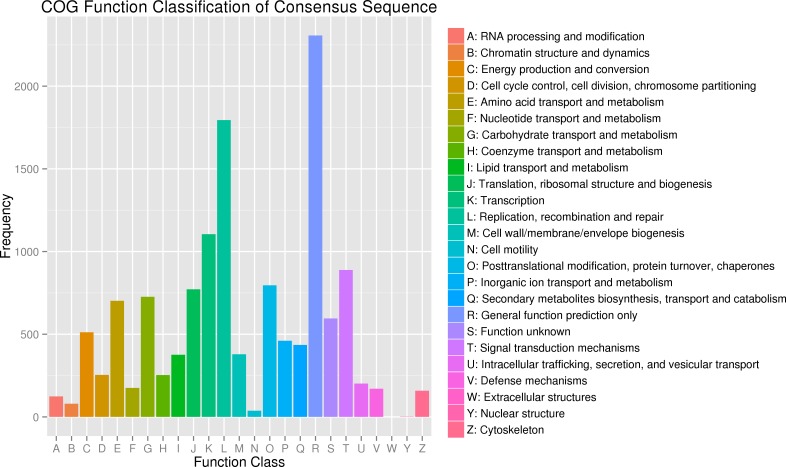
Clusters of orthologous group (COG) classification.